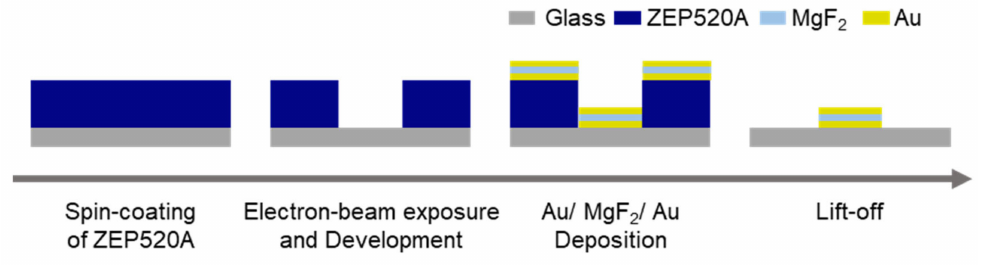
Figure 1. Schematic illustration of the fabrication process of MIM nanostructures. The bottom 30 nm thickness of Au, center 20 nm thickness of MgF 2 , and top 30 nm thickness of Au were deposited in this order using a thermal evaporator